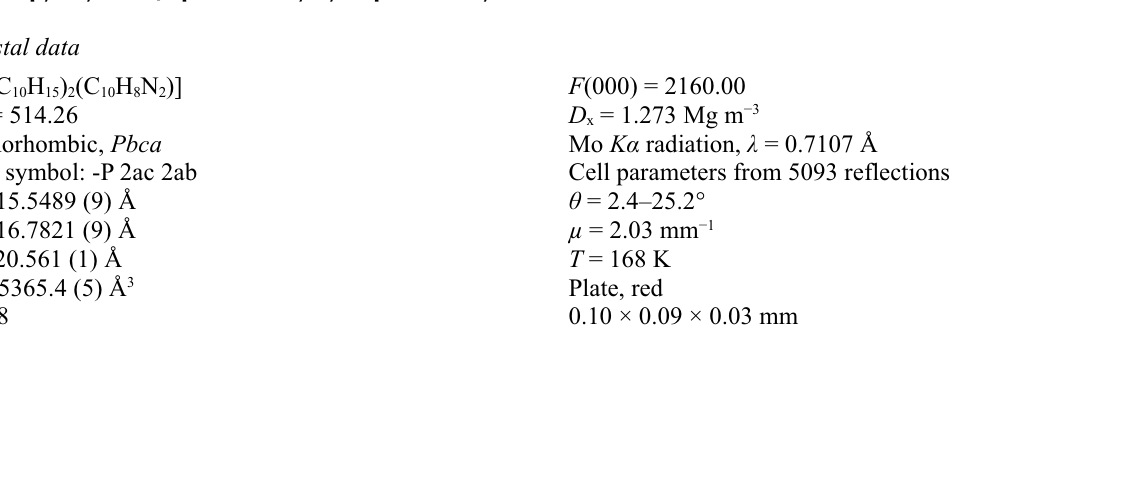
Me ) Sr(bipy), with displacement ellipsoids drawn at the 50% probability level. 5 5 2